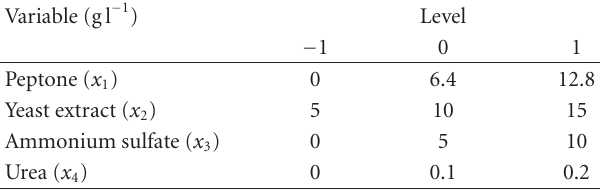
Table 1: Experimental range and levels of the independent variables used in the 2 4 full factorial design for the nitrogen source study.